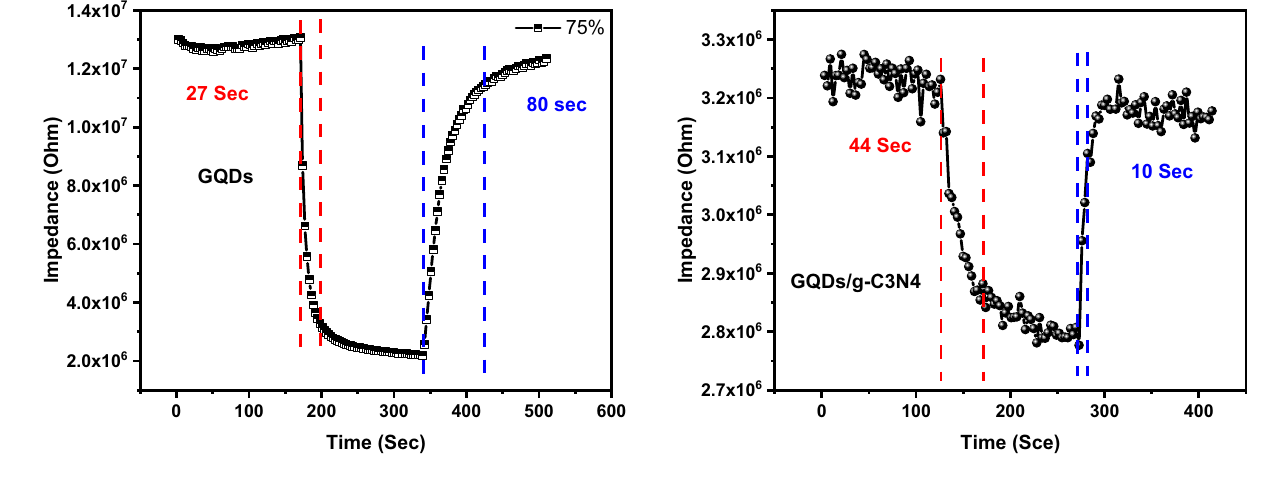
Figure 16. The response and recovery time of GQDs and GQDs/g-C3N4.